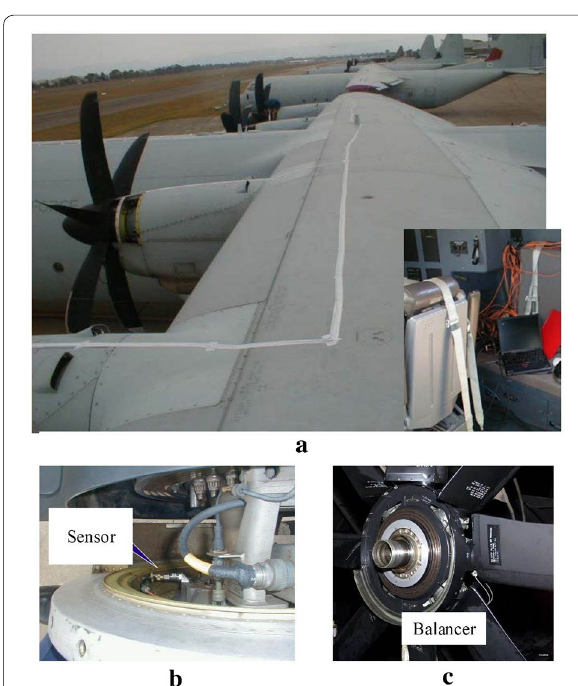
Figure 5 Physical diagram of propeller automatic balancing system: a related wiring, b vibration sensor, c balance actuator